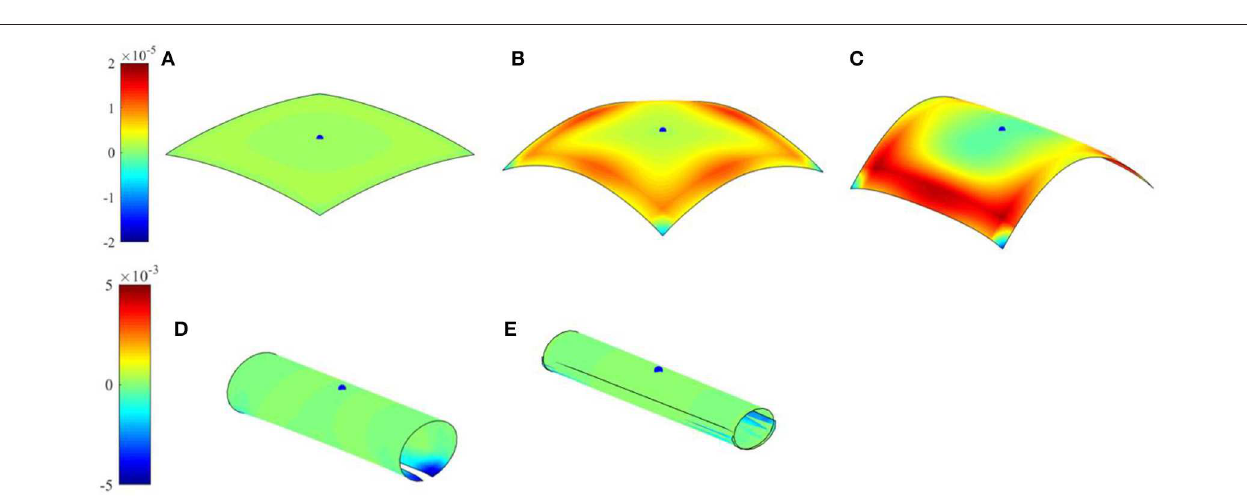
Frontiers in Materials |